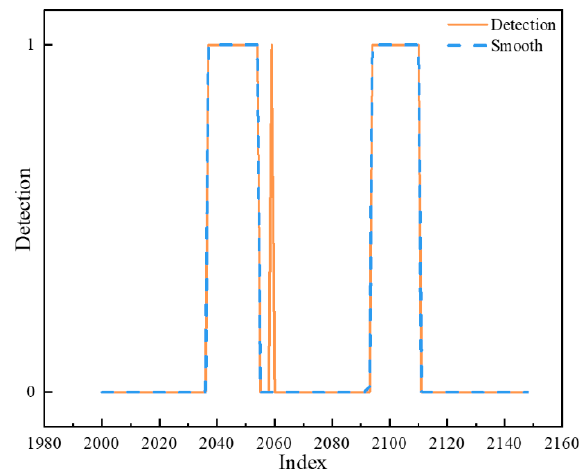
Figure 11. Abnormal detection results and